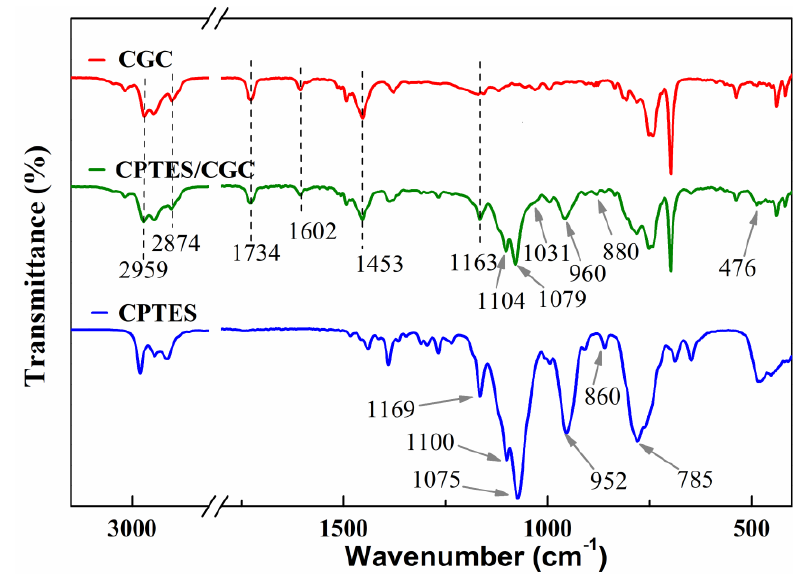
Figure 2. FTIR spectra of coating surfaces.